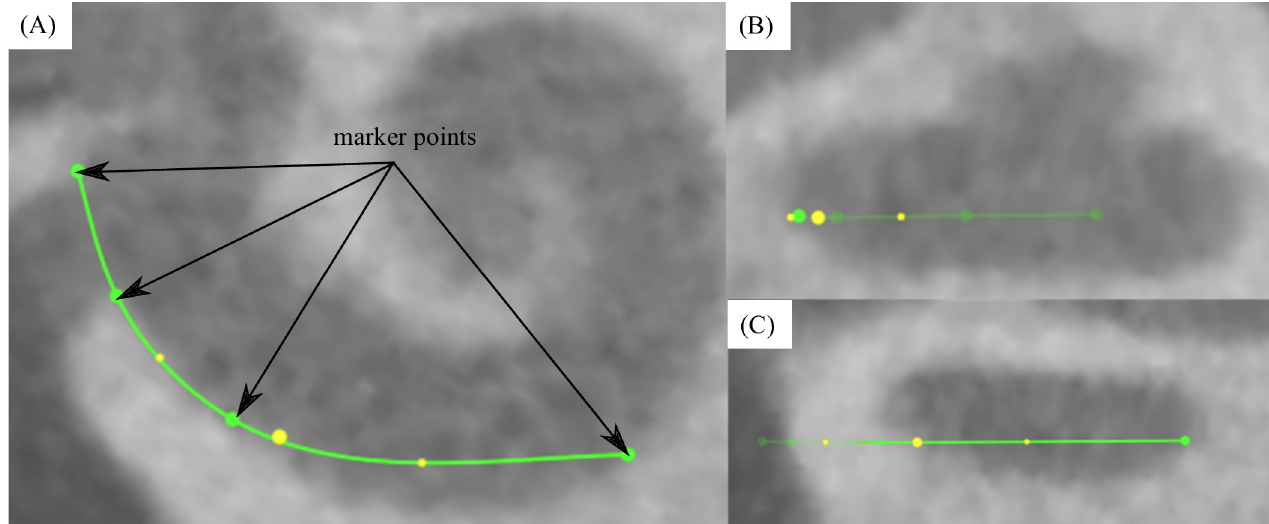
Fig 2. Spline measurement with OsiriX MD. Visualization of lateral wall tracing in OsiriX MD in top (A) and side views (B, C).